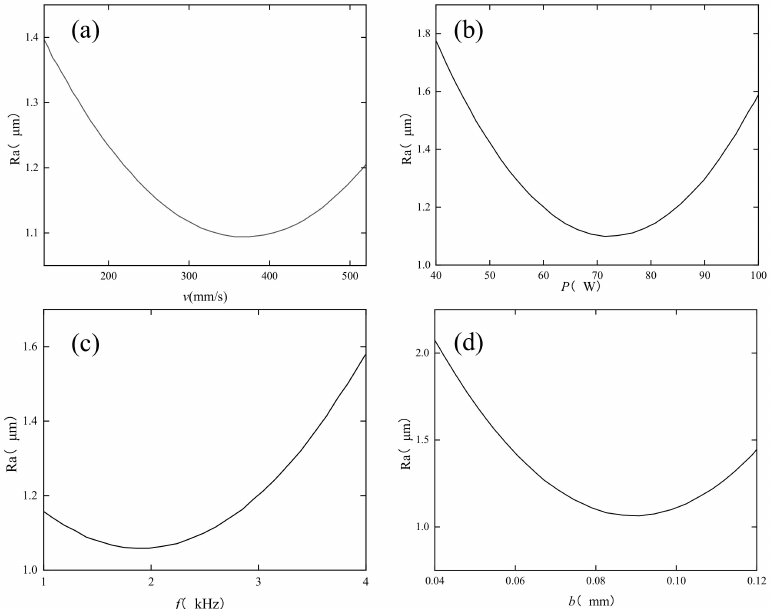
Figure 3. Effect of a single factor on surface roughness. ( a ) effect of scanning speed on surface roughness, ( b ) effect of laser power on surface roughness, ( c ) effect of pulse frequency on surface roughness, ( d ) effect of scanning spacing on surface